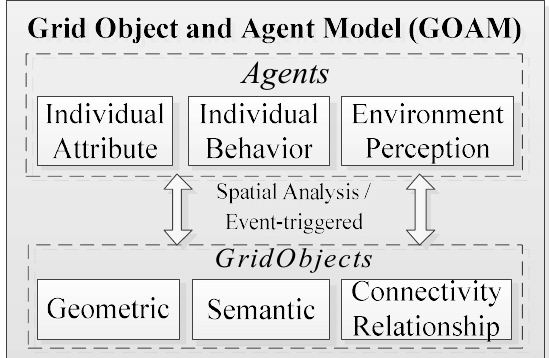
Figure 3. Interactions between the human and the environment in the GOAM.